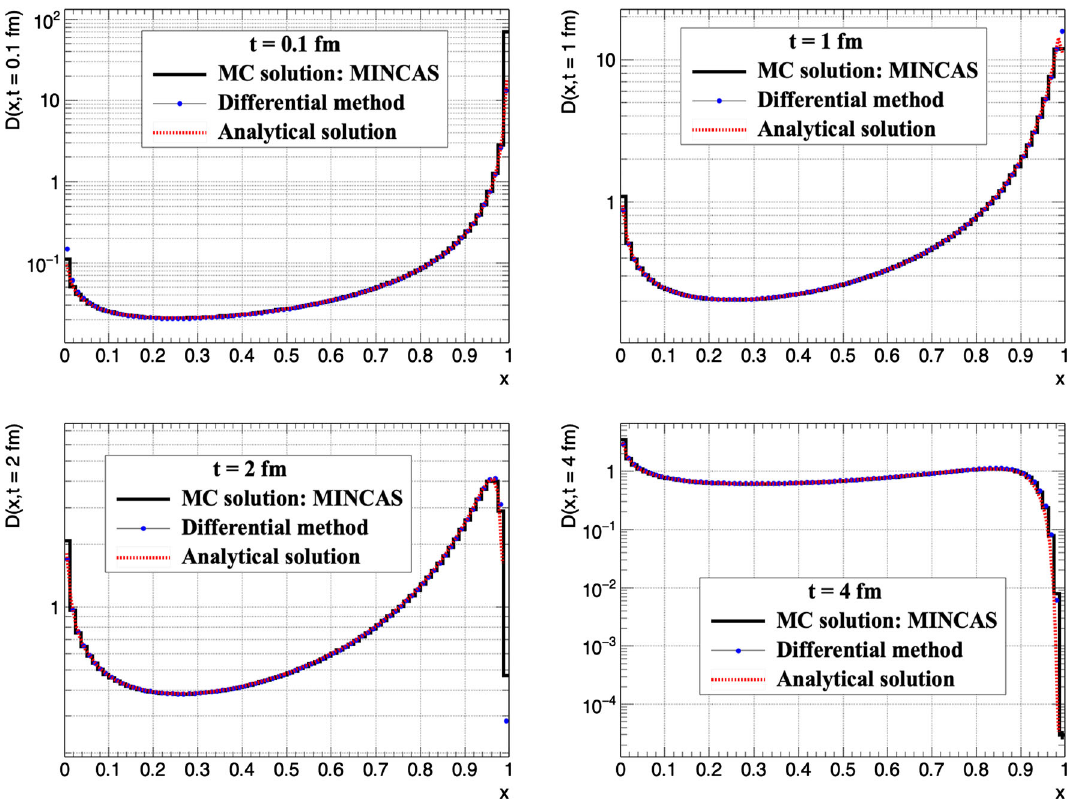
Fig. 1 Comparisons of the x distributions from the Monte Carlo program MINCAS for the solution of Eq. (21) in the case of the simplified z -kernel function with the differential method results and the analytical formula of Eq. (8), for the evolution time values: t = 0 . 1 , 1 , 2 ,